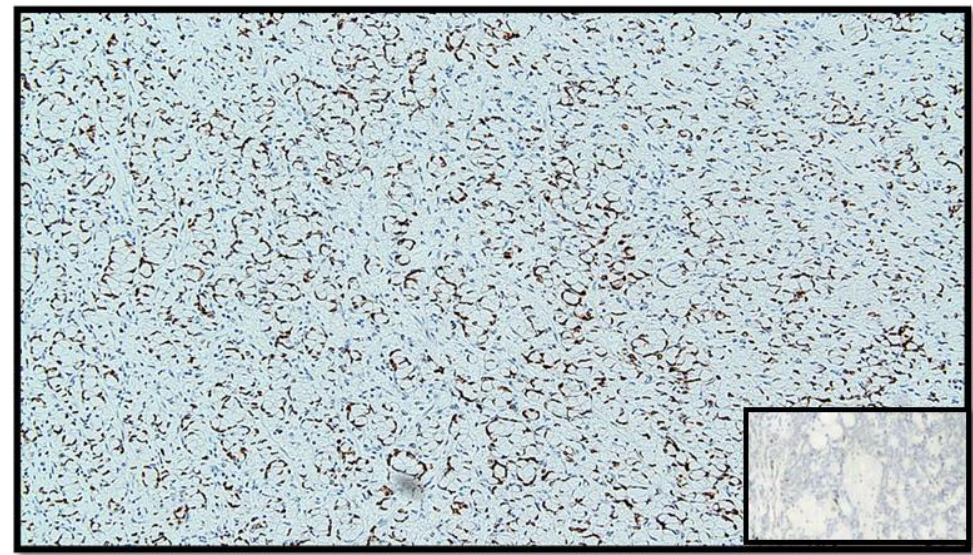
Figure 6. Immunostaining for CDX-2: note the positivity of the nucleus in tumor cells (IHC, original magnification: 40×).